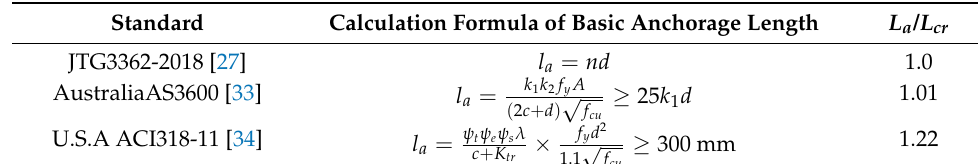
Table 7. Calculation formula of basic anchorage length (domestic and foreign codes).